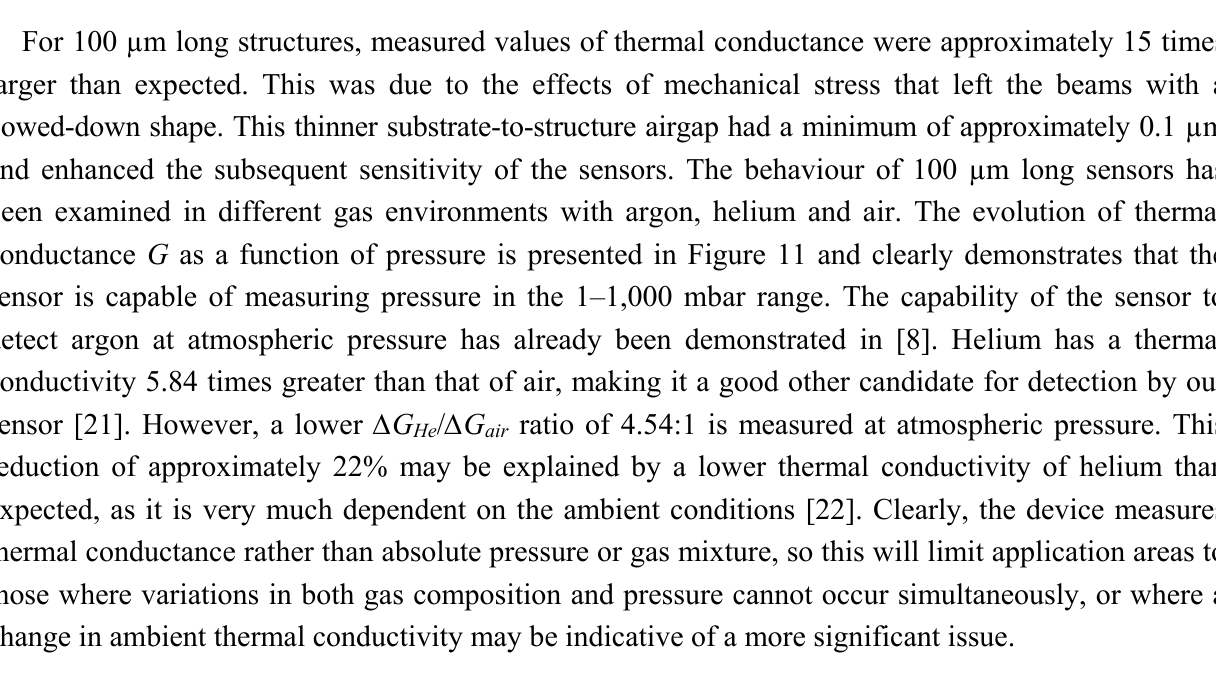
Figure 11. Illustration of the gas-sensitive nature of the thermal conductance of the